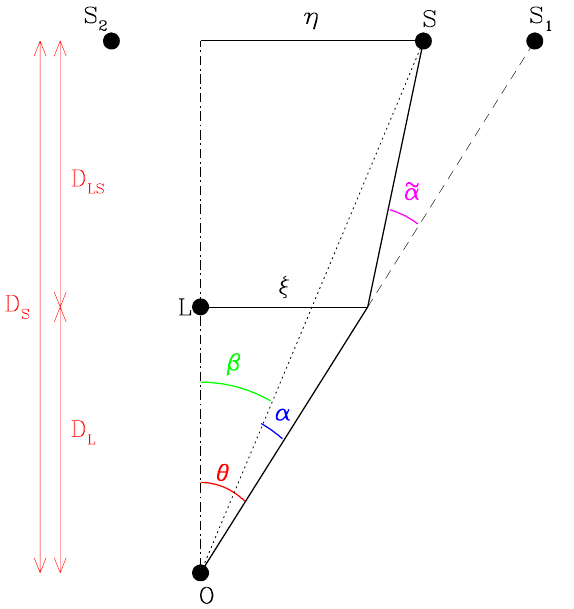
Figure 4: Basic geometry of a gravitational lens system. Image reproduced from [233]; copyright by the